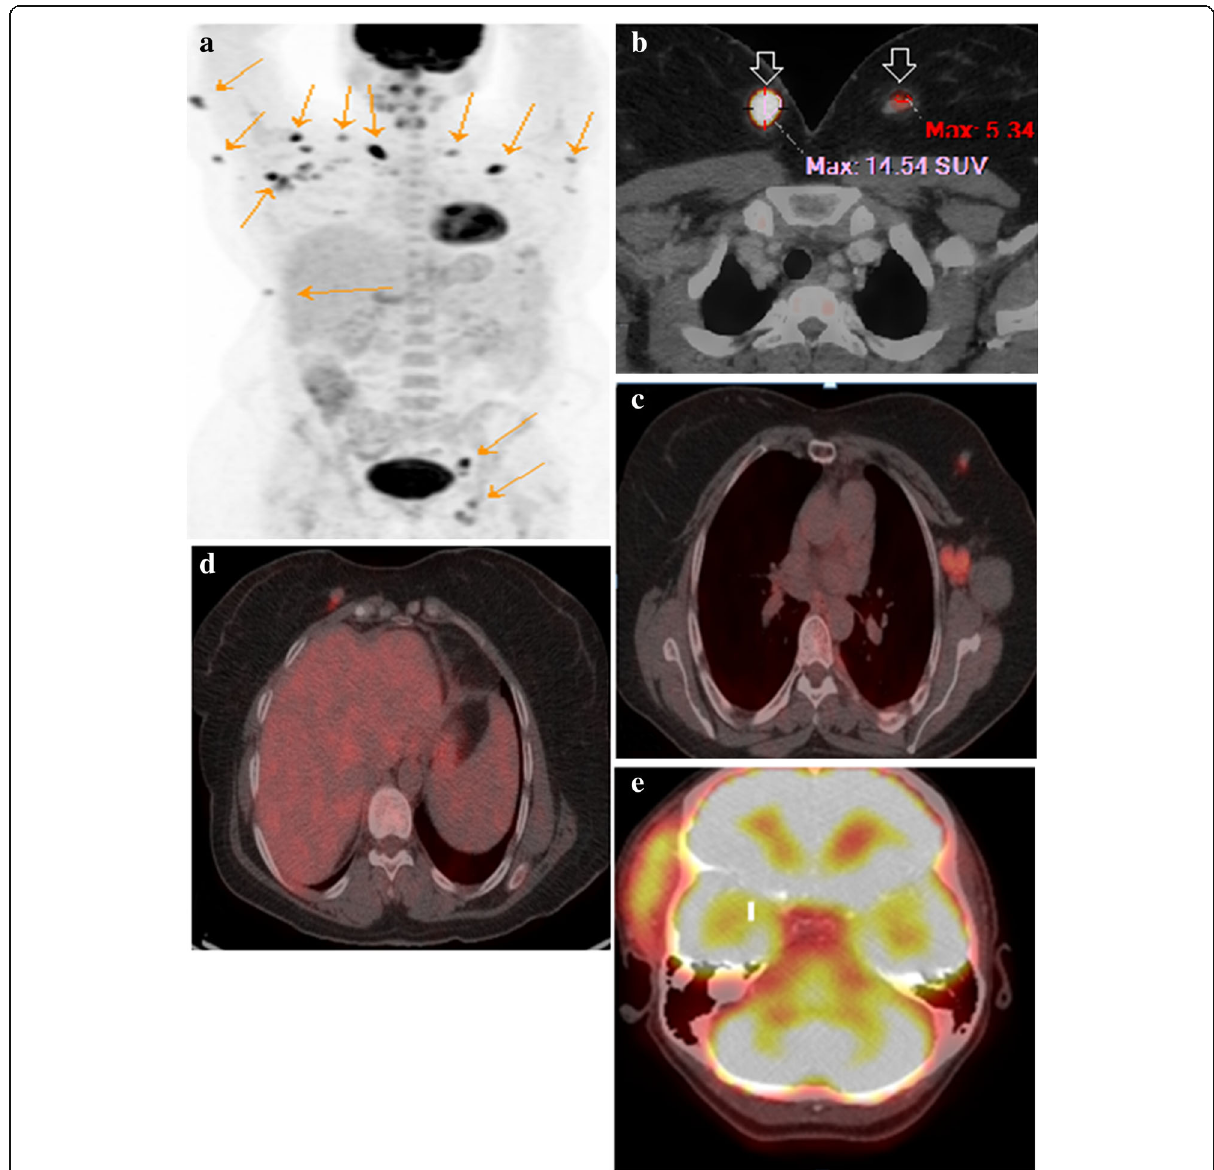
Fig. 5 a – d Breast lymphoma two different cases: case 1 a , b bilateral avid breast lesions ( b , PET CT, white arrows), associated supra and infradiaphragmatic avid LNs and subcutaneous nodules ( a , MIP image, orange arrows). Case 2 ( c , d ) showing bilateral small breast lesions with low-grade FDG uptake associated with avid axillary LNS and right temporal subcutaneous lesion ( e